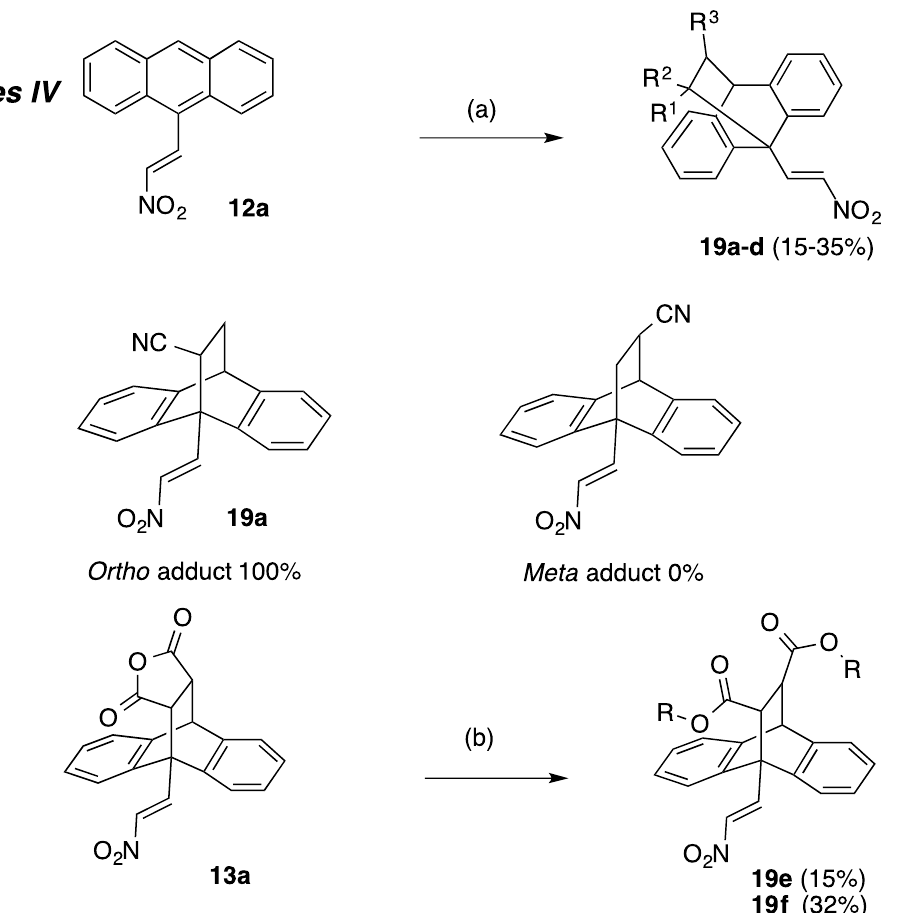
Table 1. Yields and preliminary cell viability data for compounds 13a – n , 15 (Series I) and 14a – c